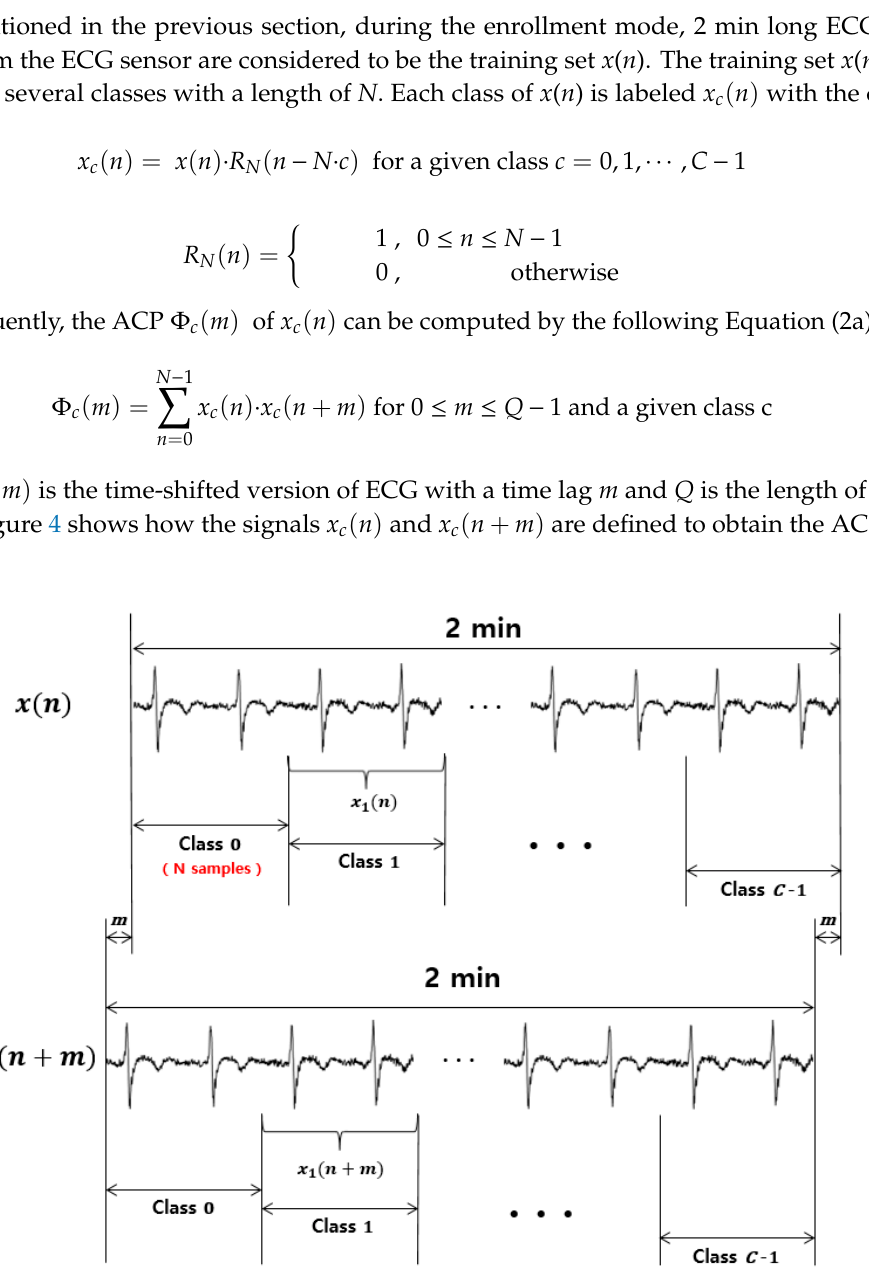
Figure 4. The two-minute-long training set x ( n ) and its time-shifted version x ( n + m ) . The training set x ( n ) is divided into C classes, each of which is N samples long. For example, x 1 ( n ) and x 1 ( n + m ) are the 1st class of x ( n ) and x ( n + m ) , respectively.